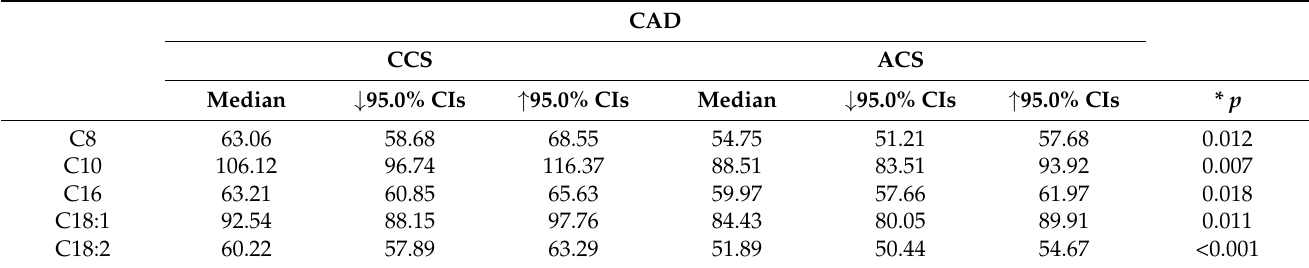
Table 3. ACS and CCS patient median level values ( µ g/L) of acylcarnitines C8, C10, C16, C18:1, and